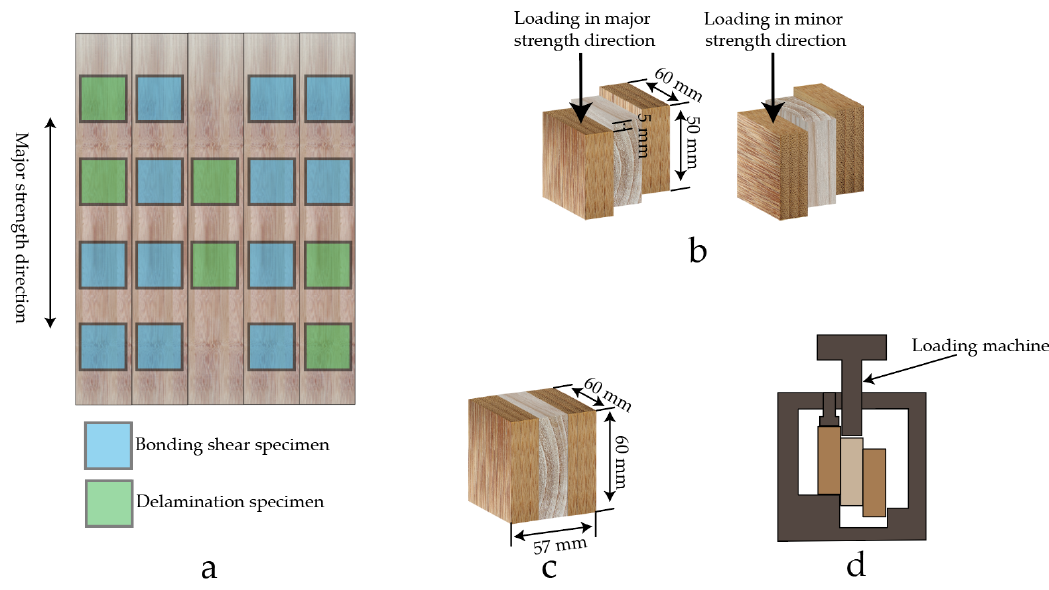
Figure 2. Sampling and testing diagram of CLBT: ( a ) sampling locations of CLBT panel, ( b ) block shear specimens, ( c ) delamination specimens, ( d ) testing diagram for block shear specimen.